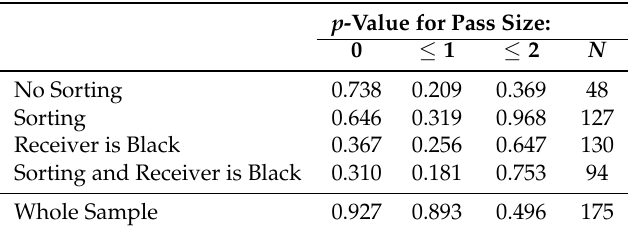
Table 11. The IAT and small